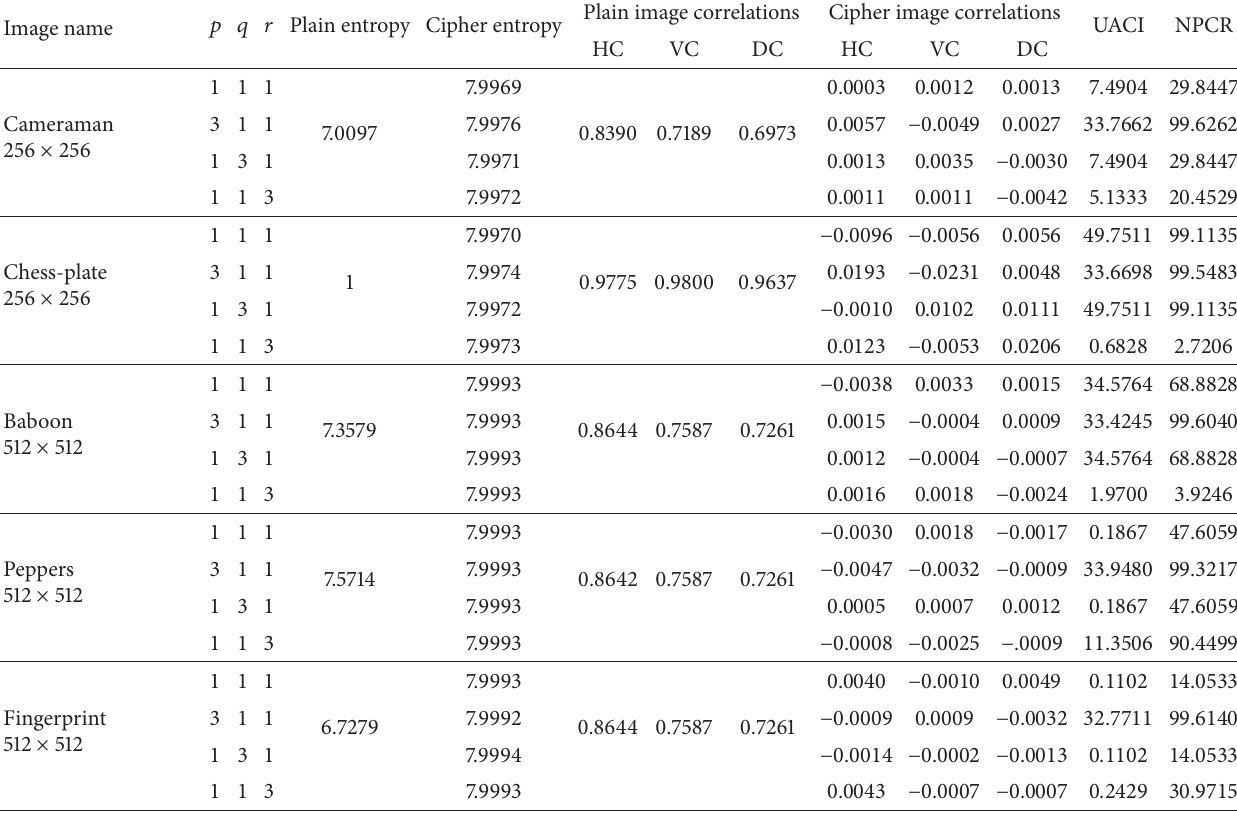
Table 15: Results of security